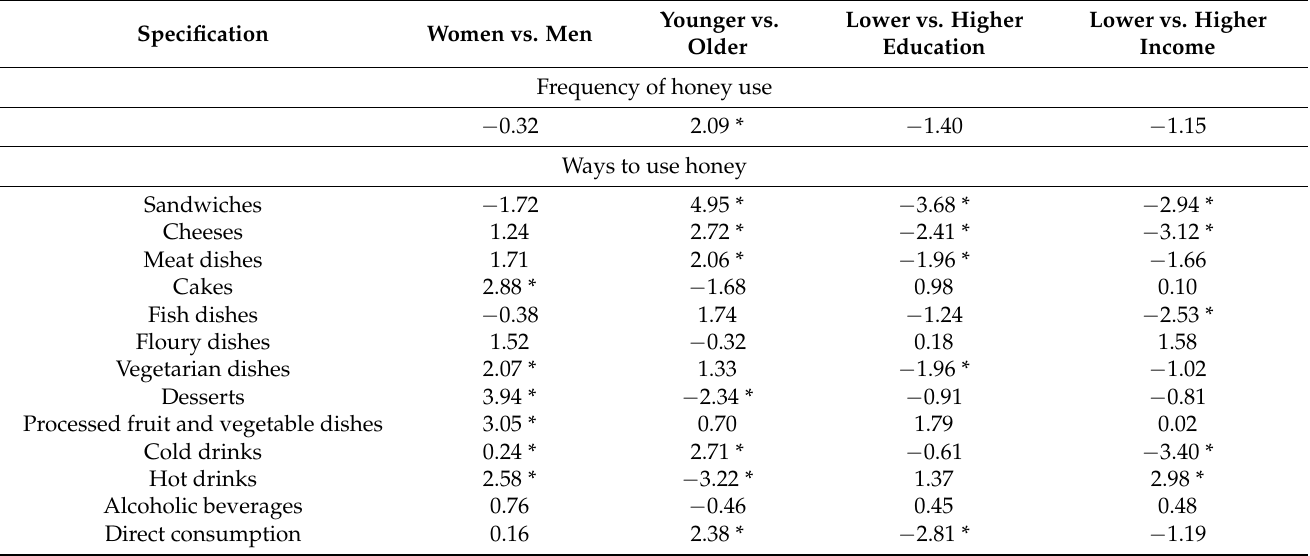
Table 2. Determinants of the frequency and patterns of honey consumption ( n = 434, Mann– Whitney